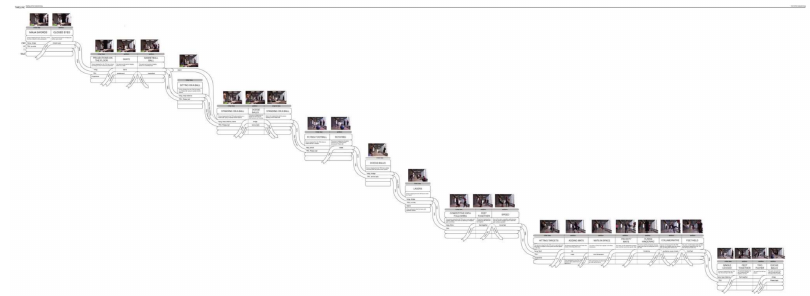
Figure 3. The whole Bodystorming Braid in miniature (a real size version does not fit in this article’s format), intended to provide the reader with a sense of the number of embodied sketches generated, grouped into nodes that have family resemblance. The Supplementary Materials contain a version of this image that can be enlarged.